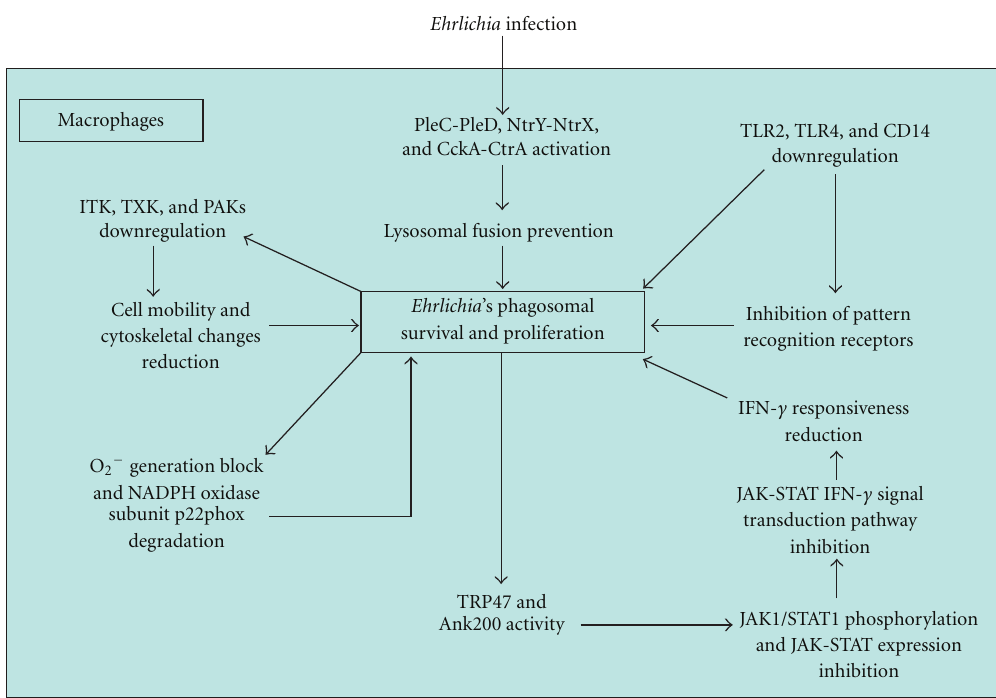
Figure 14: Ehrlichia evading innate host